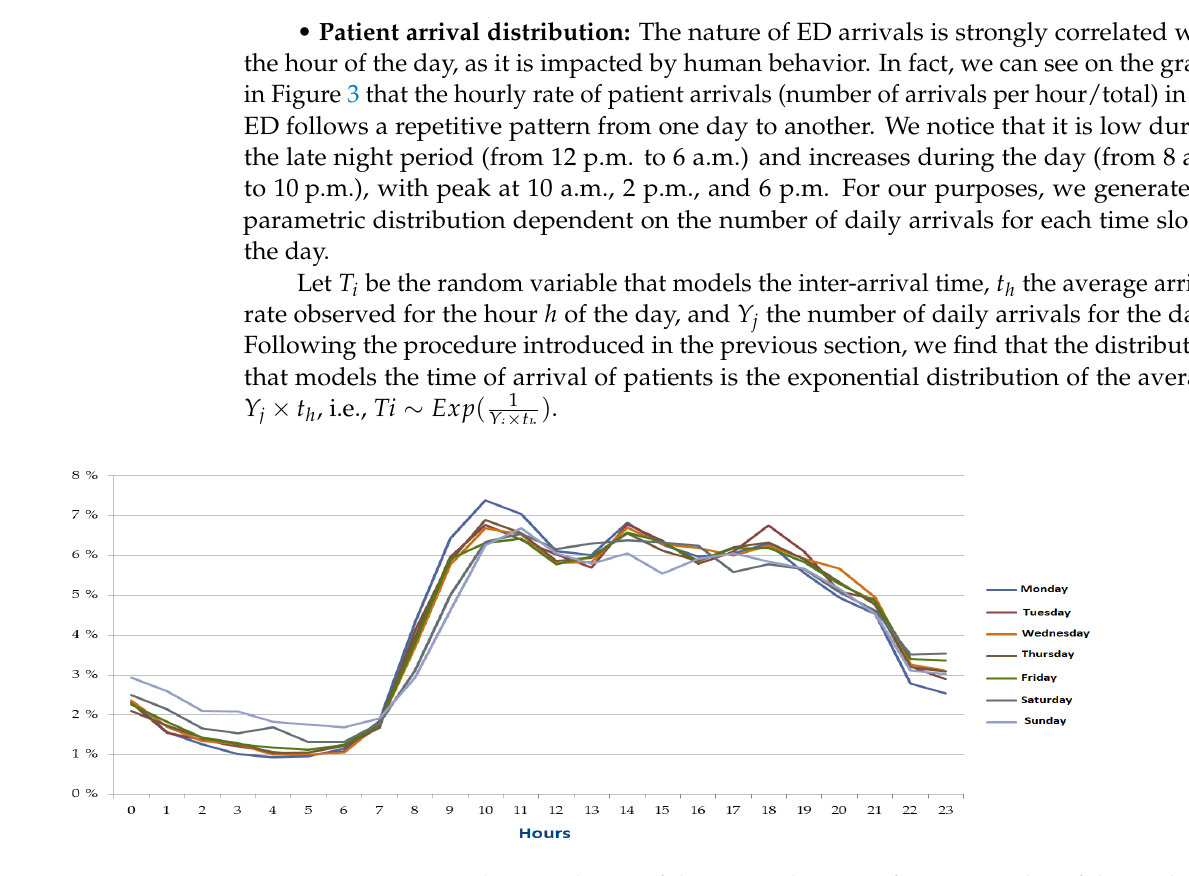
Figure 3. Patient arrival rate in the ED of the Hospital Center of Troyes per day of the week and per